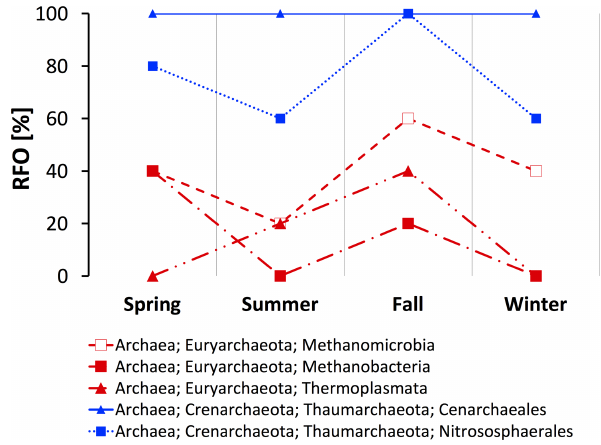
Figure 5. Seasonal variation in the relative frequency of occur- rence of dominating Euryarchaeota classes and Crenarchaeota or- ders within this